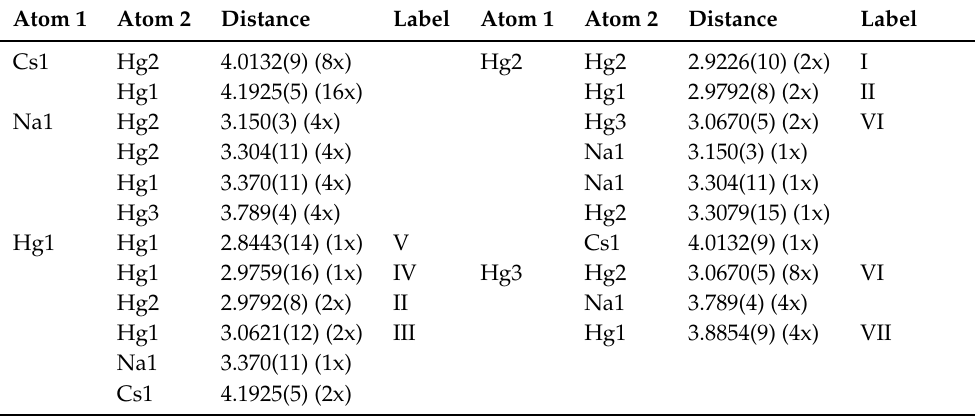
Table 5. Selected interatomic distances (and their frequencies) in CsNa 2 Hg 18 in Å. All standard deviations are given in parentheses in units of the last digit. The Hg–Hg bond labels are the same as in Figure